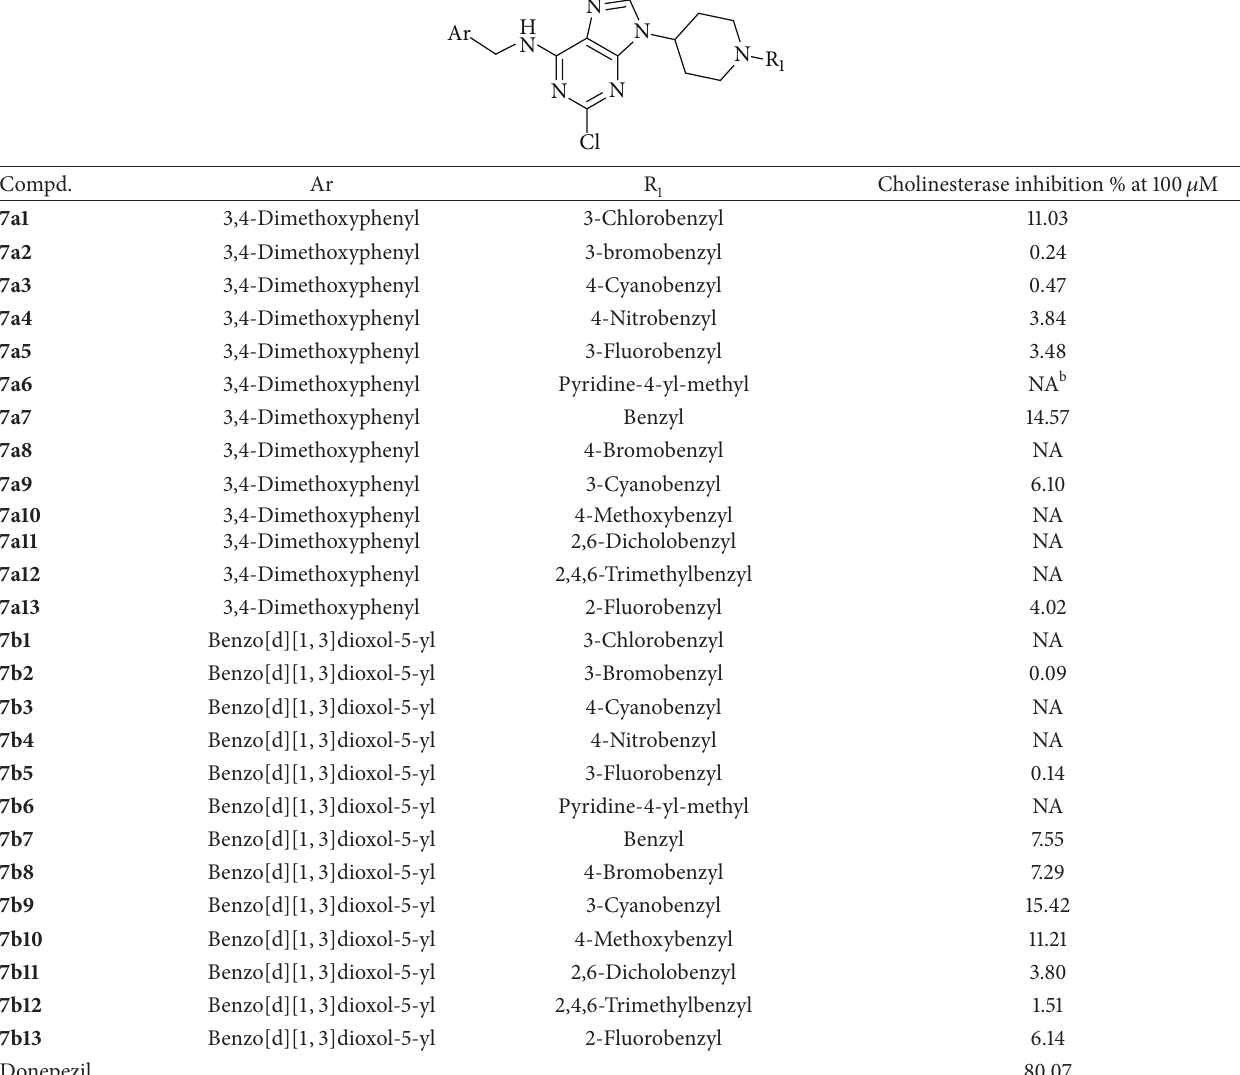
Table 1: Cholinesterase inhibition activity of 9-(1-(substituted-benzyl)piperidin-4-yl)-2-chloro-9 H -purin-6-amine derivatives a .